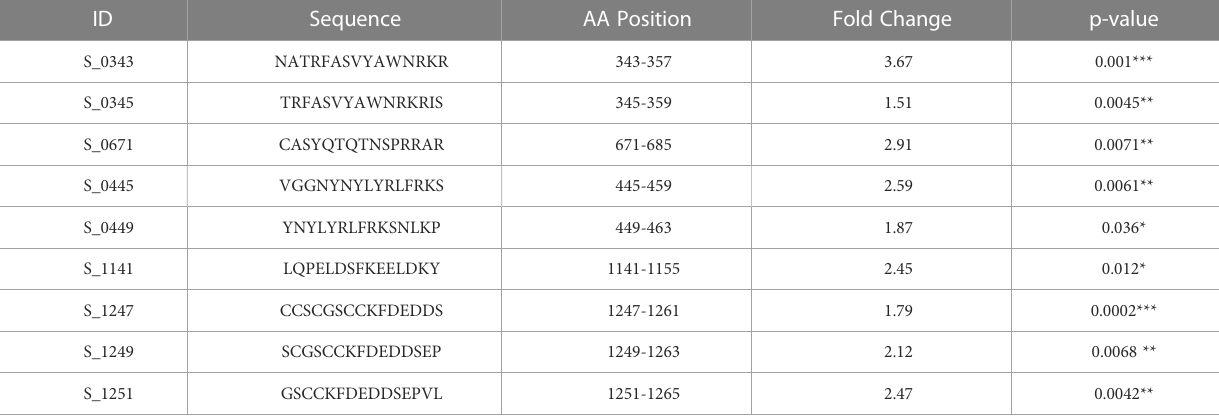
TABLE 1 Highly responsive peptide sequences of spike protein.